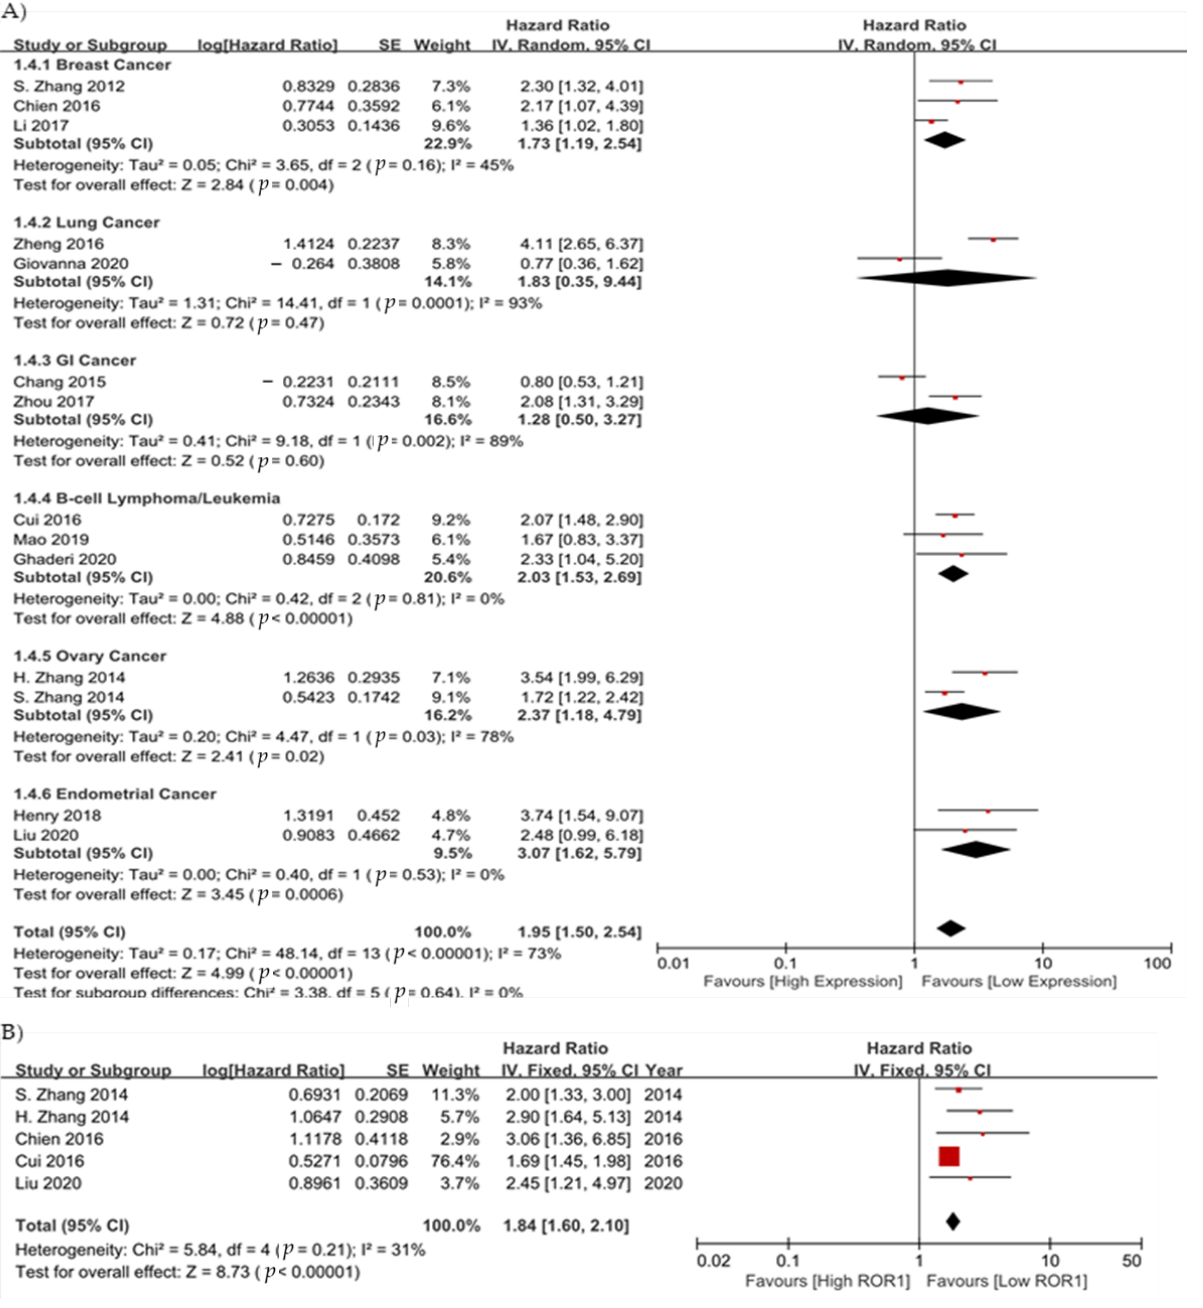
Figure 3. Forest plot showing hazard ratios for ( A ) overall survival, and ( B ) progression-free survival, according to ROR1